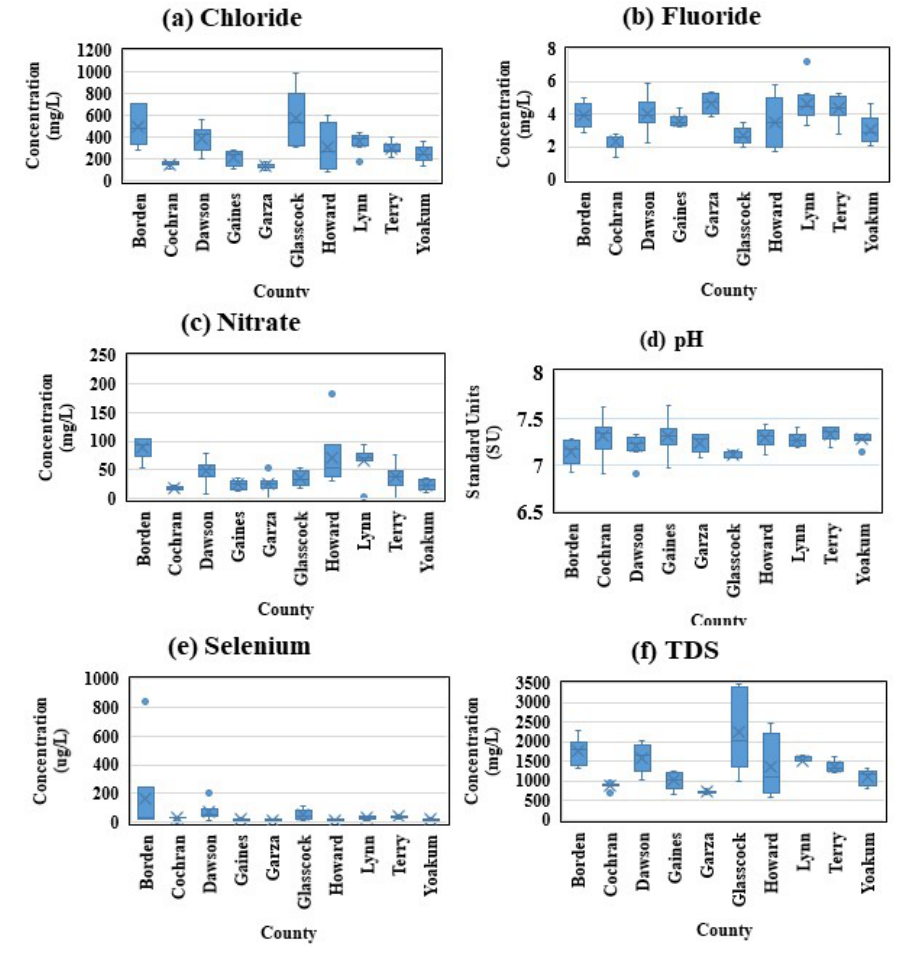
Figure 11. Box and whisker plots of ( a ) chloride, ( b ) fluoride, ( c ) nitrate, ( d ) pH, ( e ) selenium, and ( f ) TDS parameters recorded for each respective county during the research period 1990–2016. Table 1. Statistical average values of groundwater quality parameters in all counties in the study area during the research period 1990–2016.